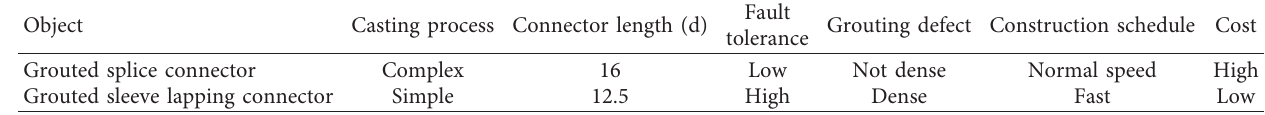
Table 1: Comparison of two connectors.